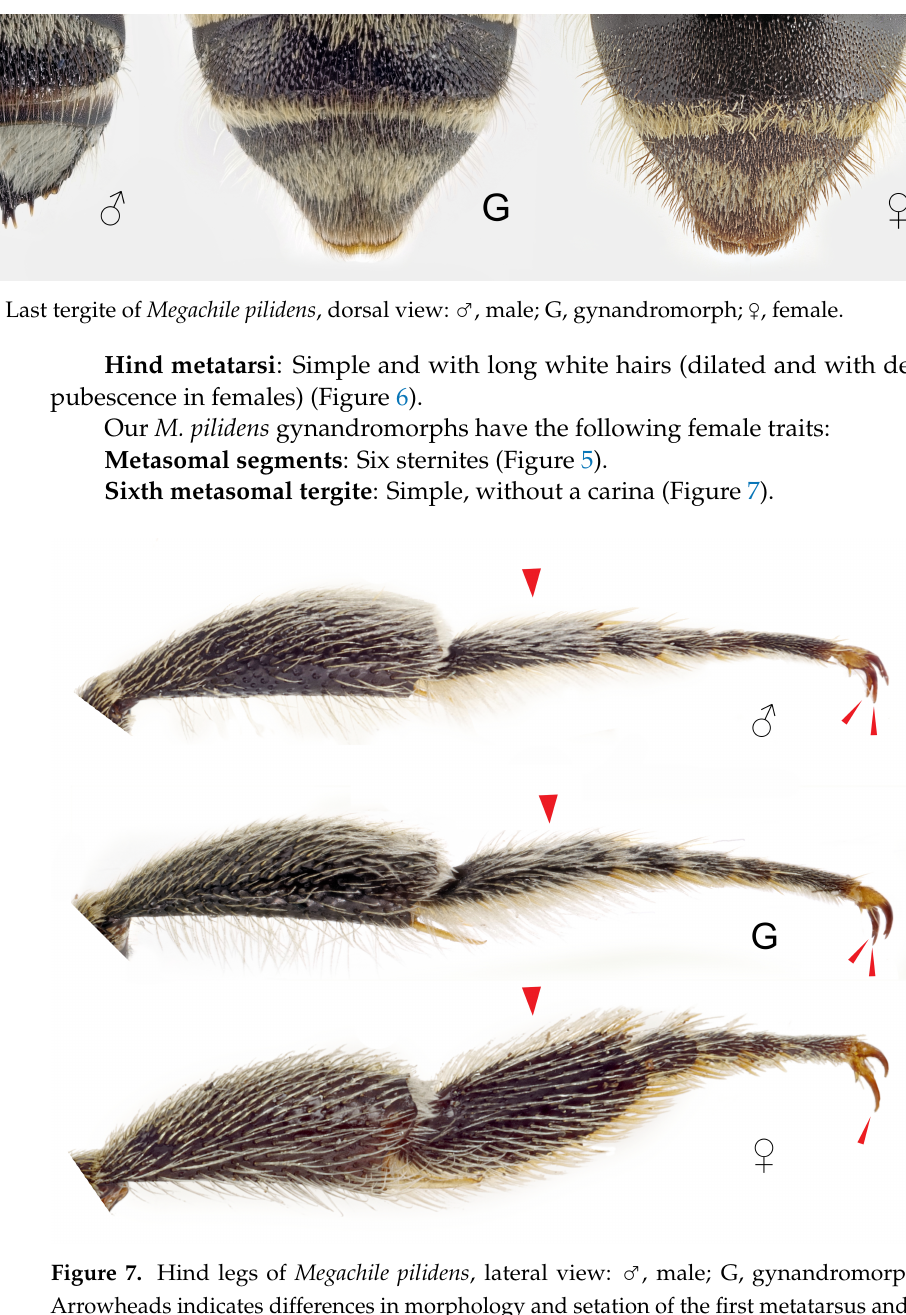
, male; G, gynandromorph; , female. ♀ ♂